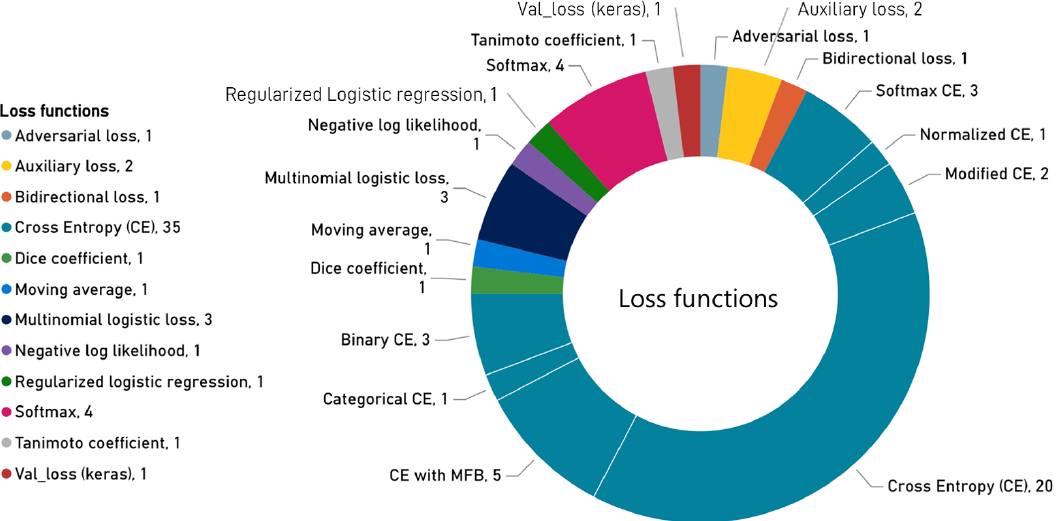
Figure 8. Overview of loss functions used to evaluate the deep learning models. The most commonly used loss in Cross Entropy (CE) loss.